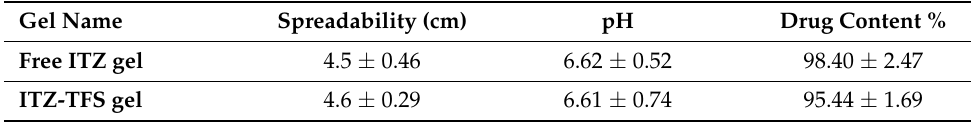
Table 7. Evaluation of the prepared ITZ